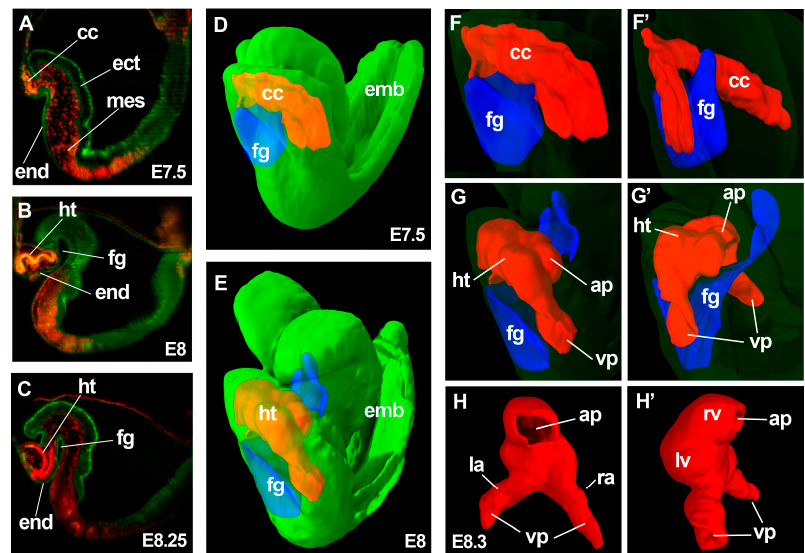
Figure 1. 3-dimensional analysis of heart tube formation. ( A – C ) show optical sections of 3D reconstructions obtained by light-sheet microscopy from E7.5 ( A ); E8 ( B ) and E8.25 ( C ) embryos. Rosa26GFP ; Mesp1 cre/+ ; R26Rtdtomato embryos are shown in ( A , B ); while a Mesp1 cre/+ ; R26RmT/mG embryo is shown in ( C ); Ectoderm and endoderm are shown in green and mesoderm in yellow ( A , B ) or red ( C ); ( D , E ) show simultaneous display of the 3D reconstructions of the foregut pocket (blue), cardiac crescent (red) and whole embryo (green) from E7.5 ( D ) and E8 ( E ) embryos; ( F – G’ ) show magnified 3D views of the cardiac region of the embryo 3D models in ( D , E ); The whole-embryo volume (green) has been transparented for appreciation of the details of the cardiac region. ( F , G ) show ventro-lateral views and ( F’ , G’ ) show dorso-lateral views; ( H , H’ ) a reconstruction of the linear heart tube from an E8.3 embryo; ( H ) shows a dorsal view and ( H’ ) a lateral view. The image indicates the structures derived at this stage from the FHF: left ventricle and part of the atria and SHF: right ventricle and part of the atria. ht , heart tube; cc , cardiac crescent; fg , foregut pocket; end , endoderm; mes , mesoderm; ect , ectoderm; emb , embryo; ap , arterial pole; vp , venous poles; lv , left ventricle primordium; rv , right ventricle primordium; la , left atrium primordium; ra , right atrium